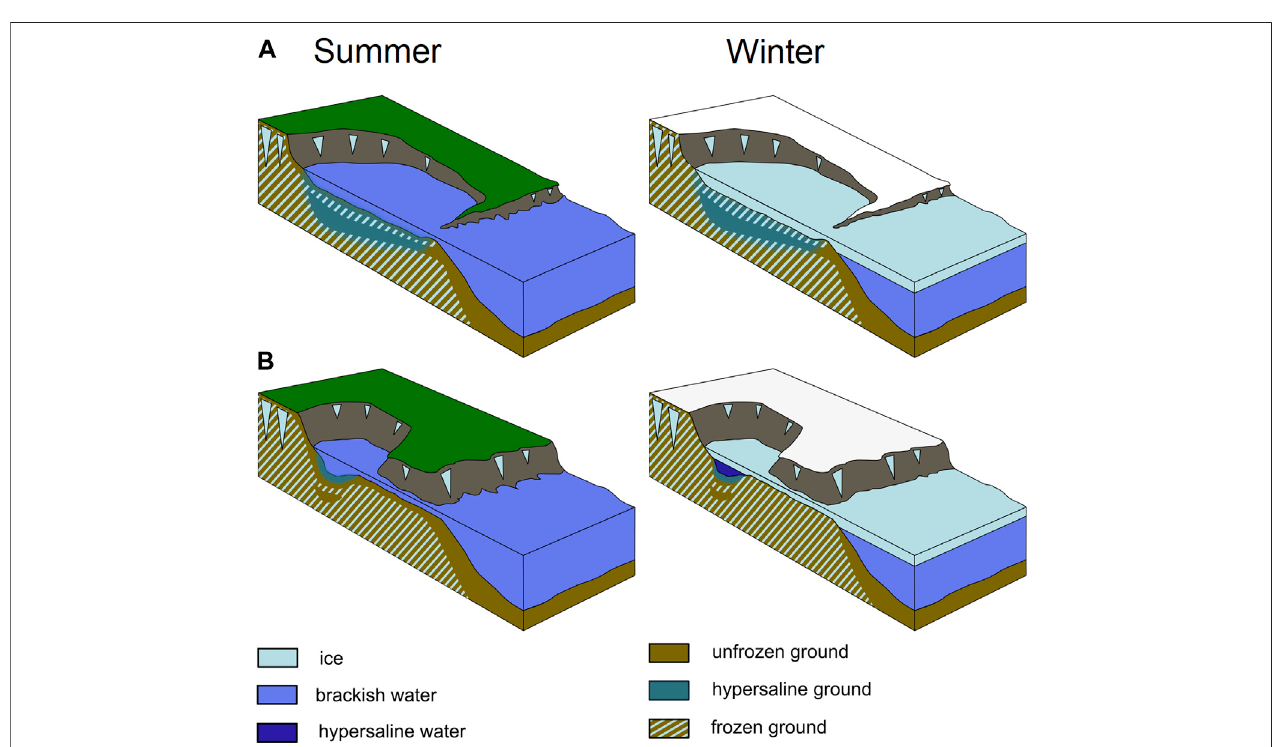
FIGURE 6 | Schematic diagram showing two types of lagoon systems in summer and winter. (A) semi-closed lagoon system (similar to Uomullyakh Lagoon). Bedfasticeinwinterleadstosaltenrichmentoftheporewateruptogreatdepth. (B) nearlyclosedlagoonsystem(similartoPolarFoxLagoon)whichisconnectedduring the open-water season only. The long and shallow channel mitigates sediment exchange. Floating ice that thickens in winter leads to salt enrichment of free water and upper sediment. Modi fi ed after Angelopoulos et al. (2020a).